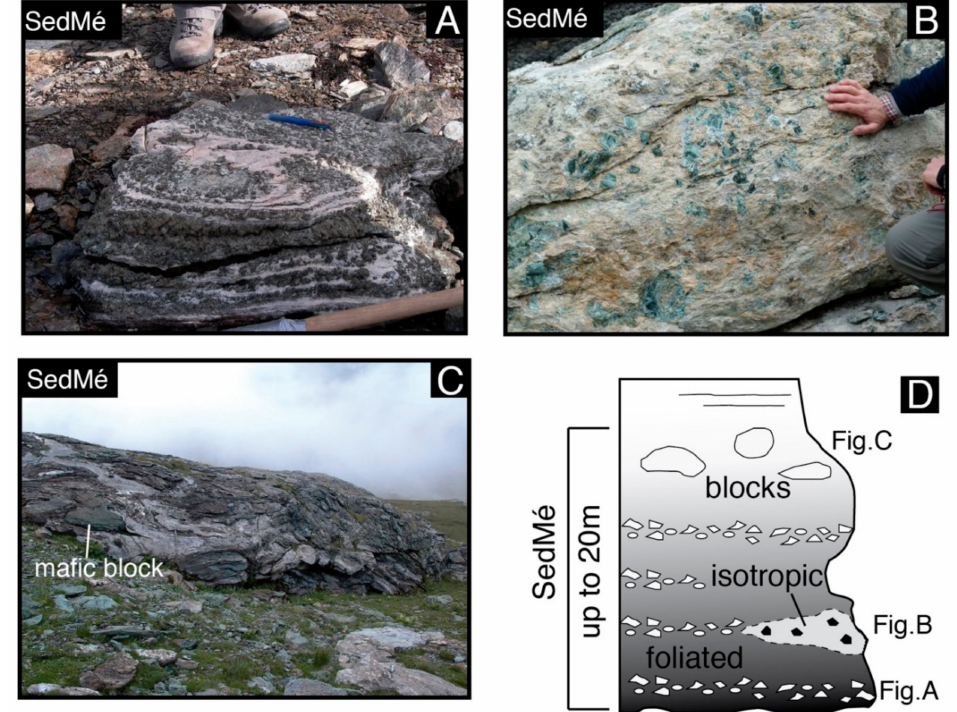
Figure 5. Outcrop views of the sedimentary m é lange (SedM é ) unit. ( A ) Clast-supported type showing a foliated texture defined by centimeter- to decimeter-thick horizons of metabreccia consisting of angular, subangular, or elongated clasts of serpentinite, embedded within a whitish Cb-rich matrix. Pen for scale. ( B ) Matrix-supported type characterized by an isotropic texture defined by a whitish-greenish matrix with disseminated ultramafic clasts composed of fibers of Srp growing radially from the centre of the clast. ( C ) Matrix-supported type including blocks of serpentinite, veined serpentinite or ophicarbonate, and mafic rocks. The mafic block is ca. 50 cm sized. ( D ) Conceptual cartoon illustrating the internal fabric of the SedM é